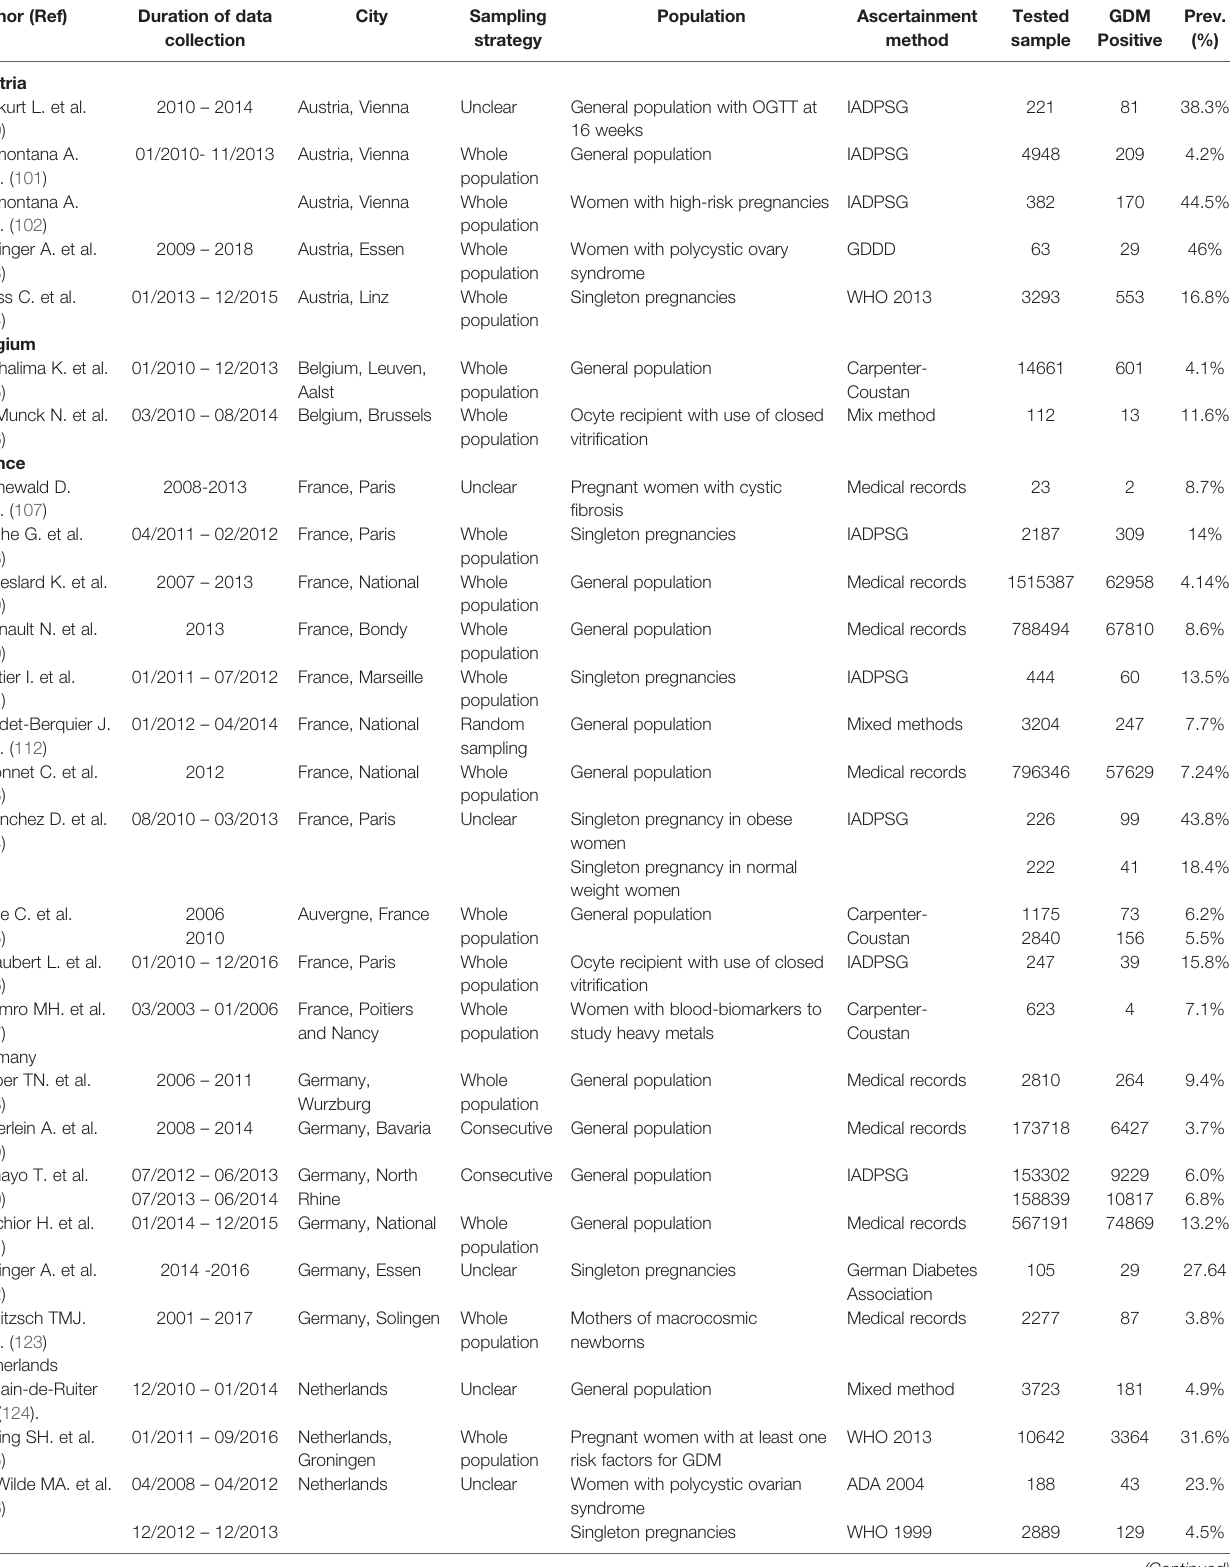
TABLE 3 | Baseline studies characteristics from Western